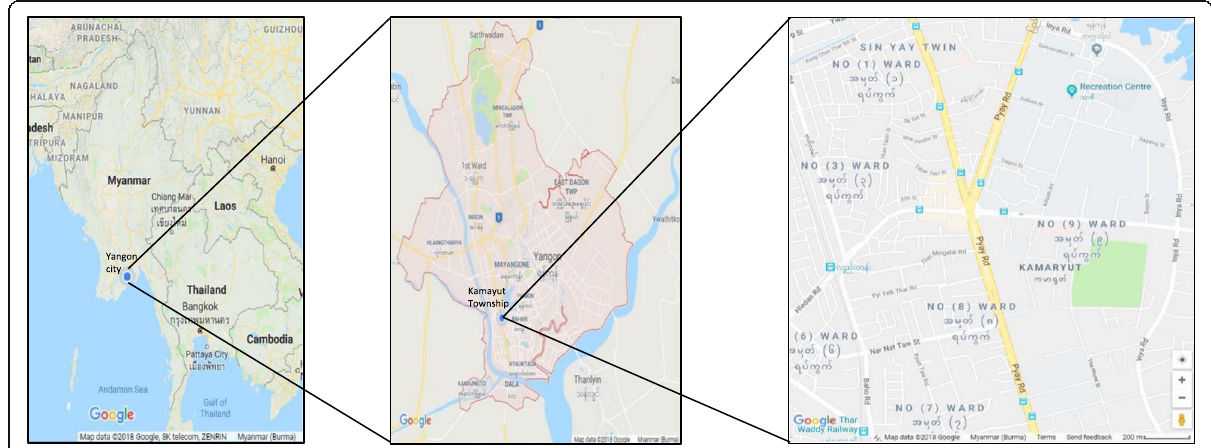
Fig. 2 Location of sampling area in Kamayut Township, Yangon, Myanmar. Kamayut Township was selected for the phase II measurement of PM 2.5 concentration as traffic in this township was congested. (Source from Google map)